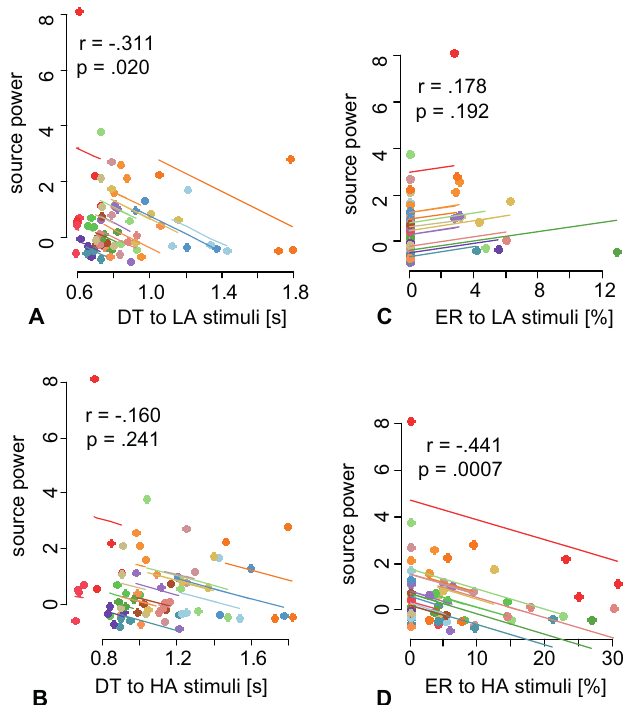
Figure 5. Results of the correlation analysis: Regression plots illustrate the relationship between SP and DT to LA stimuli ( A ); SP and DT to HA stimuli ( B ), SP and ER for LA stimuli ( C ); SP and ER for Ha stimuli ( D ). The colored dots correspond to each participant’s data; the lines have the same slope estimated for these participants via correlation analysis with repeated measures.